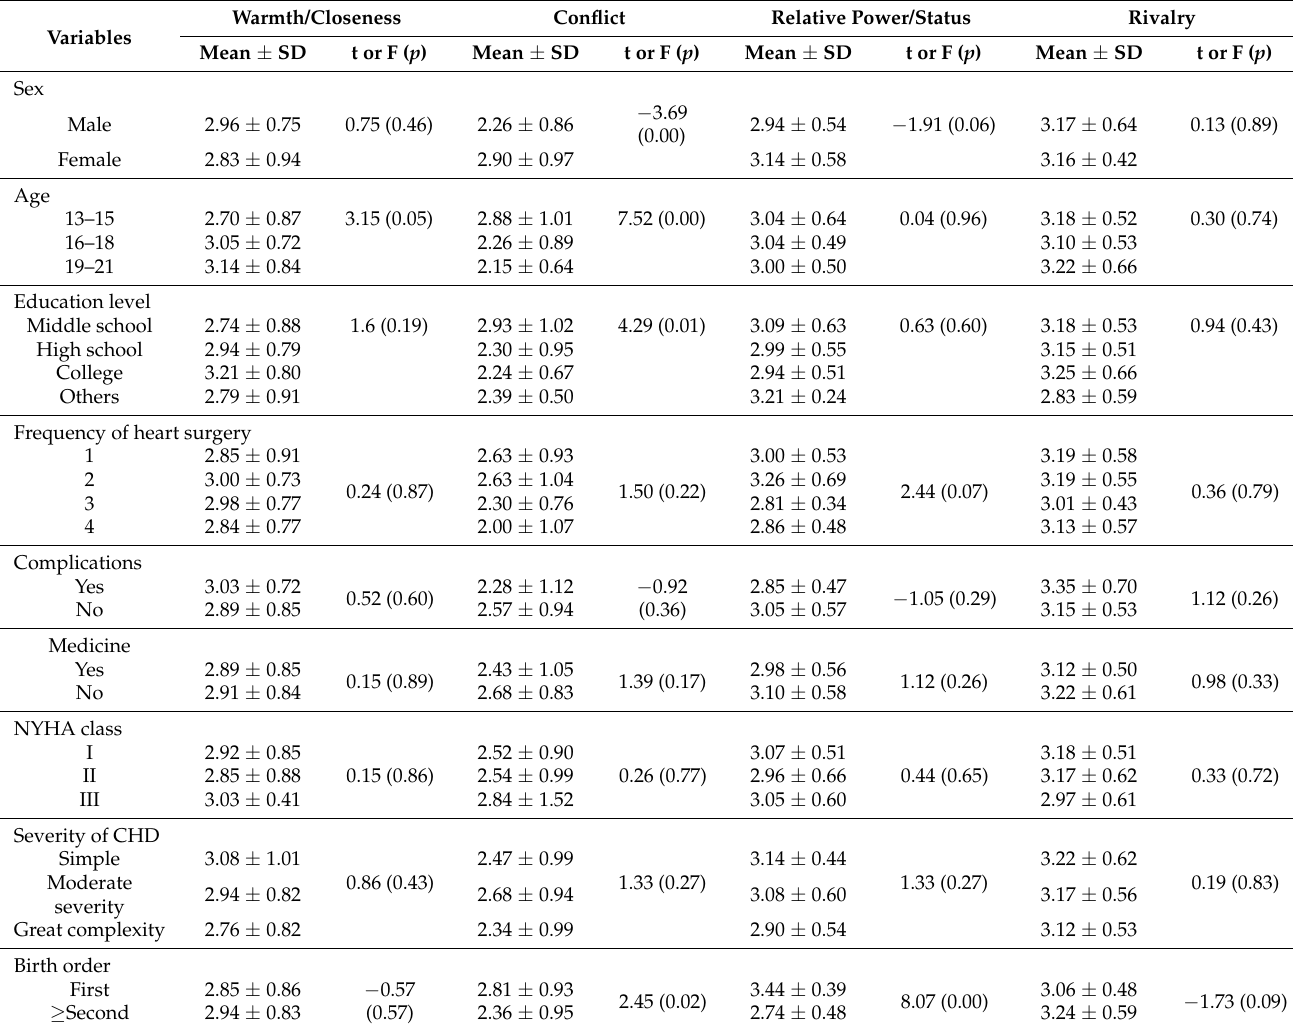
Table 3. Sibling relationships according to participant characteristics.